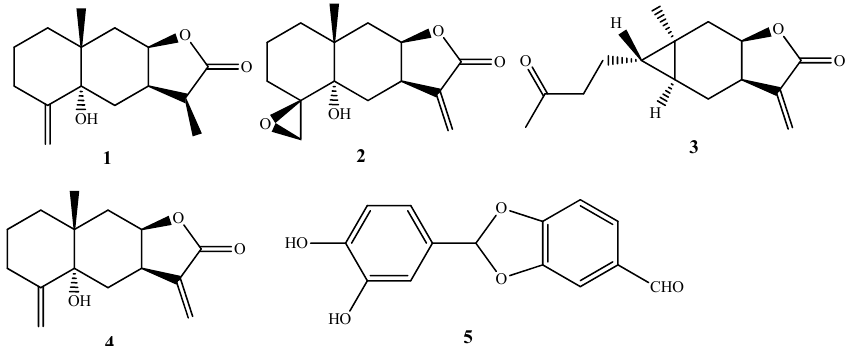
Figure 1. Structures of compounds 1 – 5 . 11(13)-dihydrotelekin ( 1 ), 4(15)- β -epoxyisotelekin ( 2 ), carabrone ( 3 ), telekin ( 4 ) and one aldehyde, 2-(3 (cid:48) ,4 (cid:48) -dihydroxyphenyl)-1,3-benzodioxole-5- aldehyde ( 5